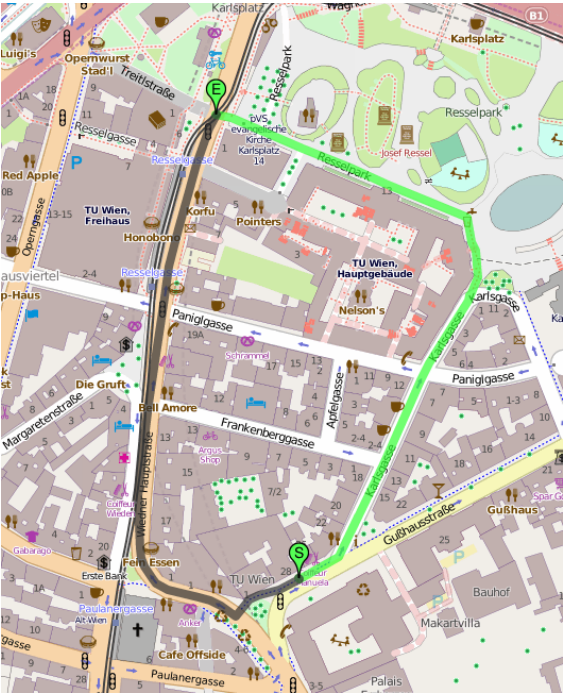
Figure 2. The most comfortable route (green one) computed by considering people's affective responses, comparing to its shortest counterpart (gray